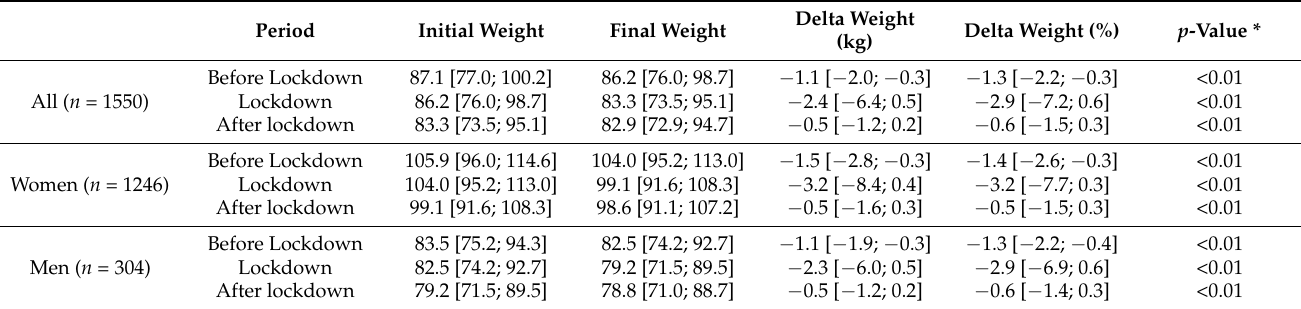
Table 1. Description of weight loss and rate of weight loss before, during and after COVID19 lockdown periods.